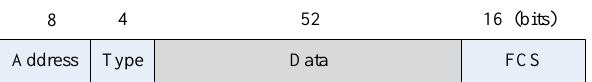
Figure 4. The structure of the insertion DATA